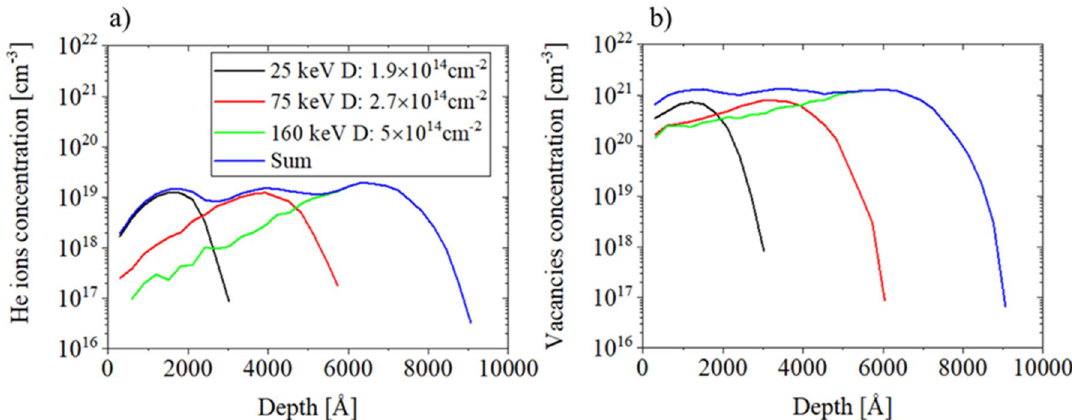
Figure 1. TRIM simulation of the depth profile of ( a ) implanted He ions concentration and ( b ) vacancies concentration in the GaN layer with 20 nm SiN cap on the top after multiple-step He ion implantation. The legend is the same for both